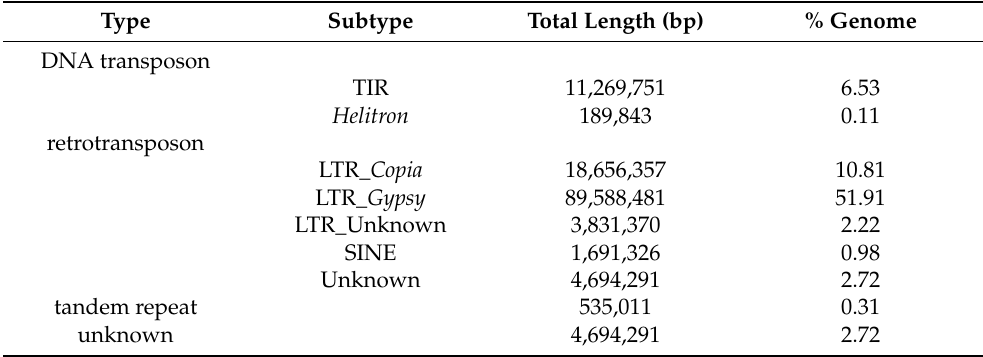
Table 2. Identification of repetitive DNA elements in short arm of H. villosa 6V